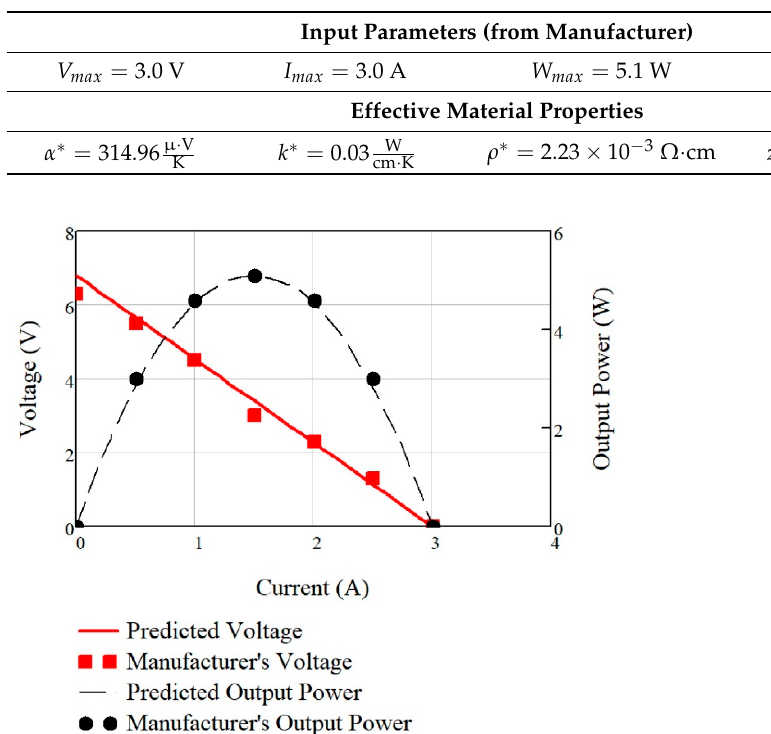
Table 1. The results of effective material properties for (TMG-127-1.0-0.8) at T h = 200 ◦ C, T c = 30 ◦ C, n = 127, A e = 1 mm 2 , and L e = 1.35 mm.